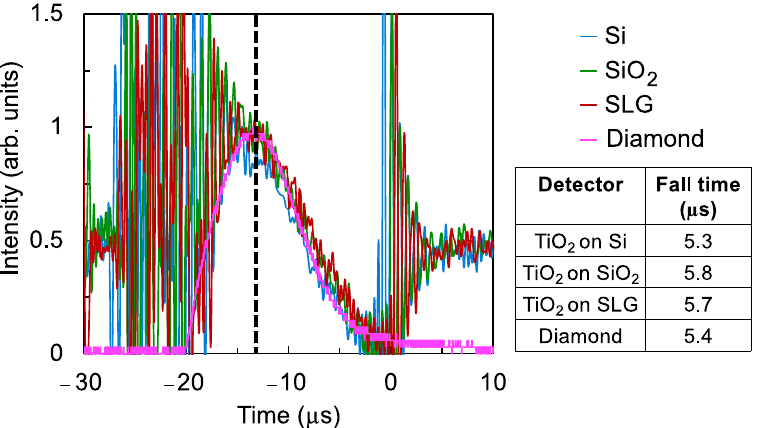
Figure 5. Time response of the TiO 2 thin film detectors. For comparison, the time response of a commercial diamond UV sensor is also shown.